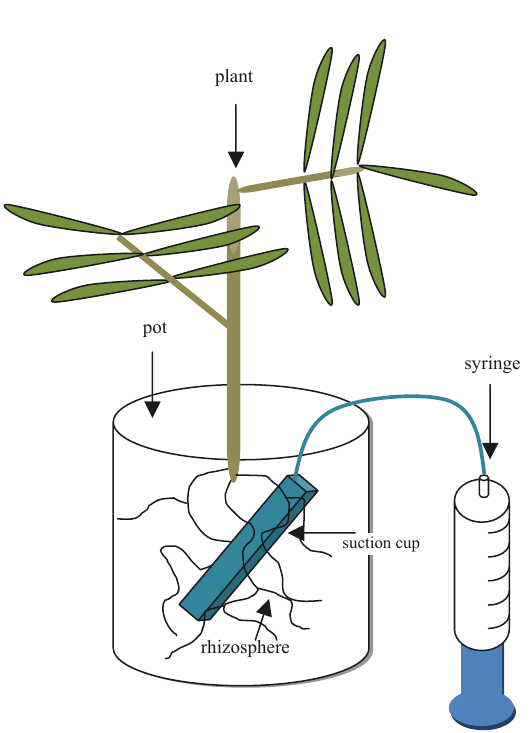
Figure 1. Design of the pot experiment for obtaining the soil solution.